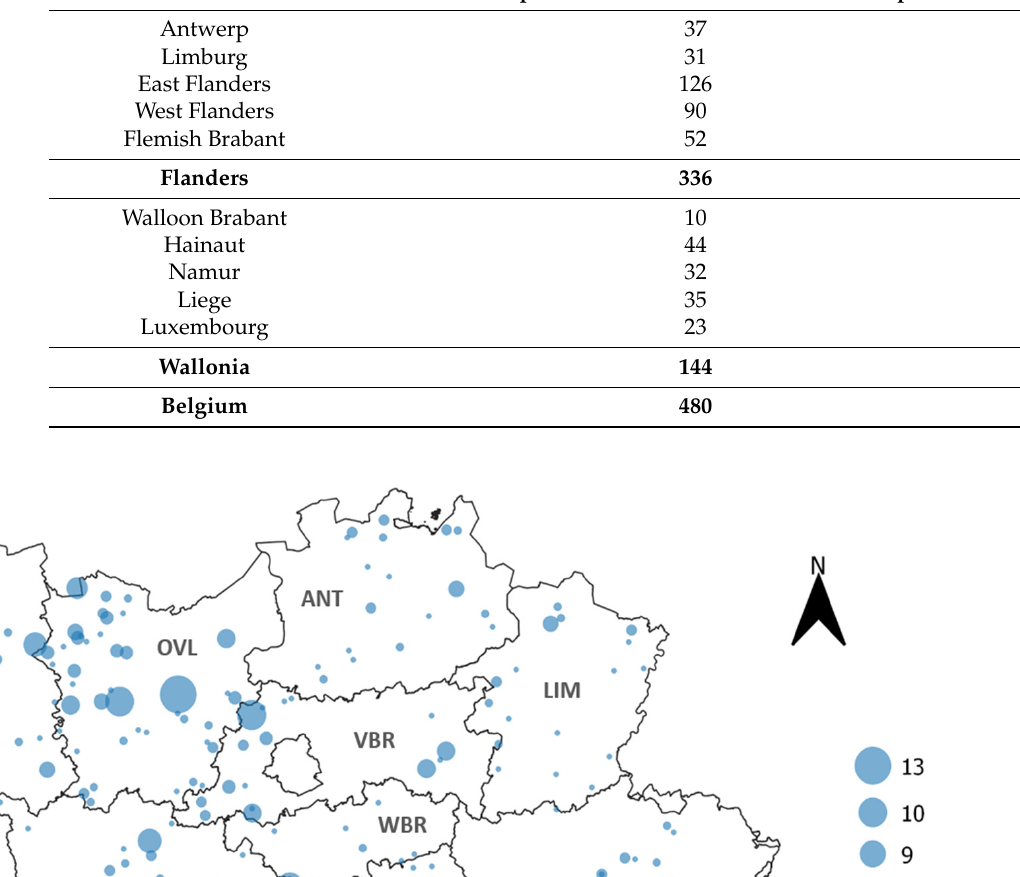
Table 1. Number of samples selected from each province.